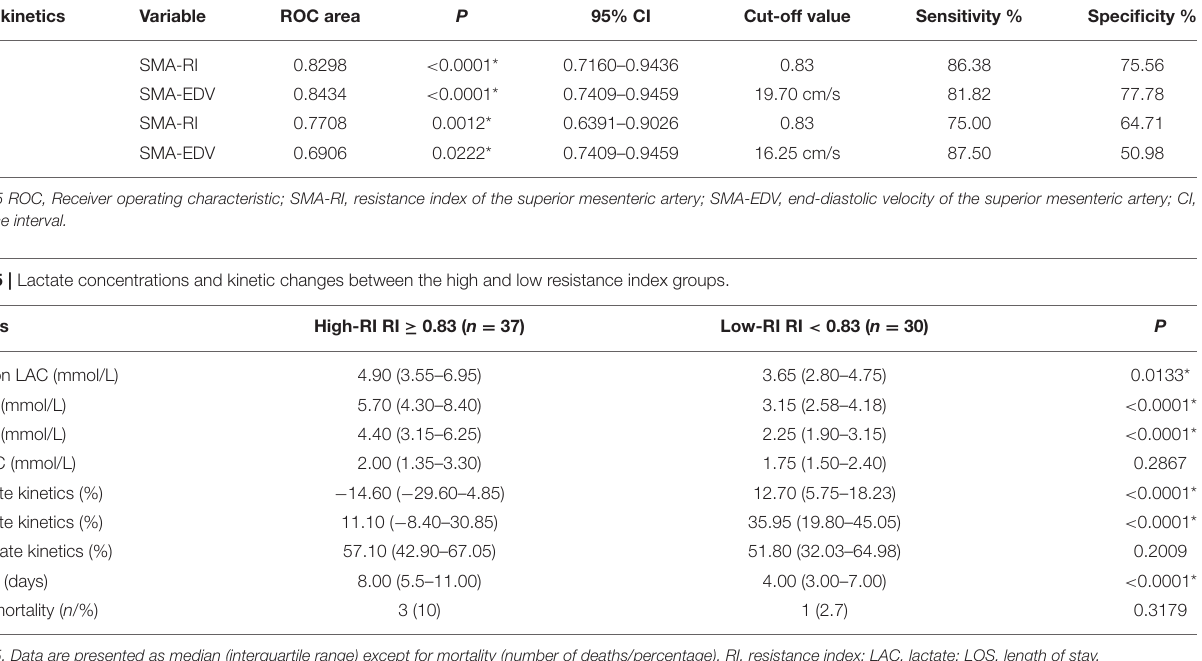
TABLE 4 | Receiver operating characteristic curve analysis of superior mesenteric artery resistance index and end-diastolic velocity in predicting lactate kinetics. Lactate kinetics